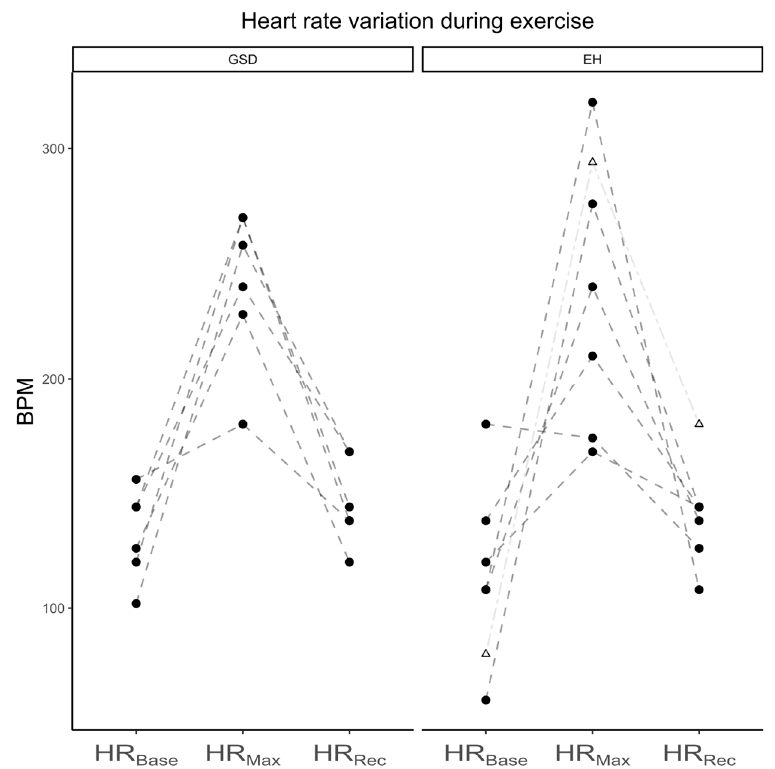
Figure 1. Heart rate variation during exercise in German shepherd dogs (GSDs) and Eurohounds (EHs) at T 2mth . BPM: beats per minute; EHs: Eurohounds; GSDs: German shepherd dogs; HR Base : baseline heart rate; HR Max : maximal heart rate during activity; HR Rec : heart rate during recovery; Δ : values of EH α , outlier EH.